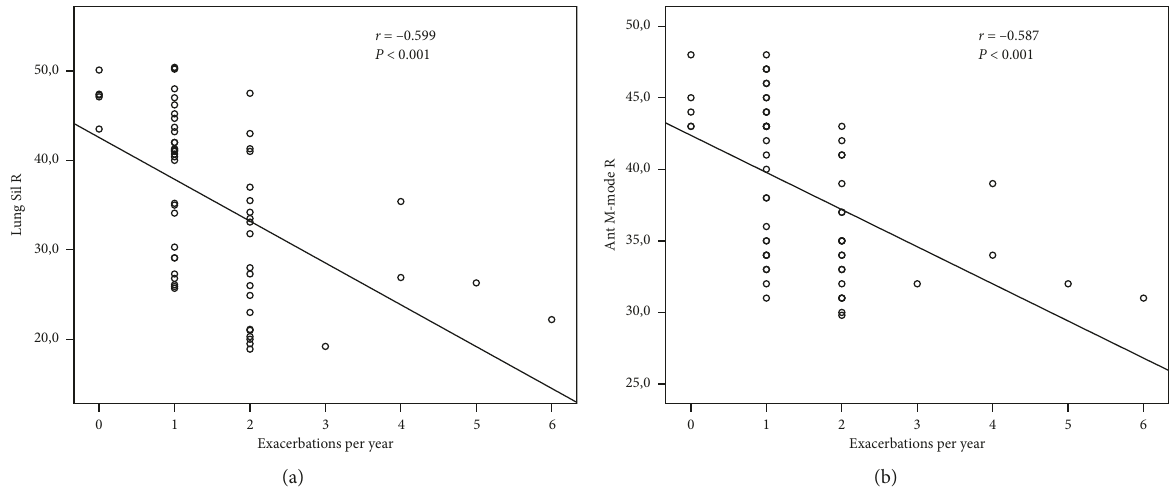
Figure 5: Correlation between (a) Lung Sil R (mm) and number of exacerbations per year and (b) Ant M-Mode R (mm) and number of exacerbations per